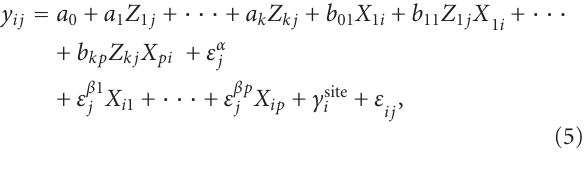
model with trait-environment interaction term against the null model without this